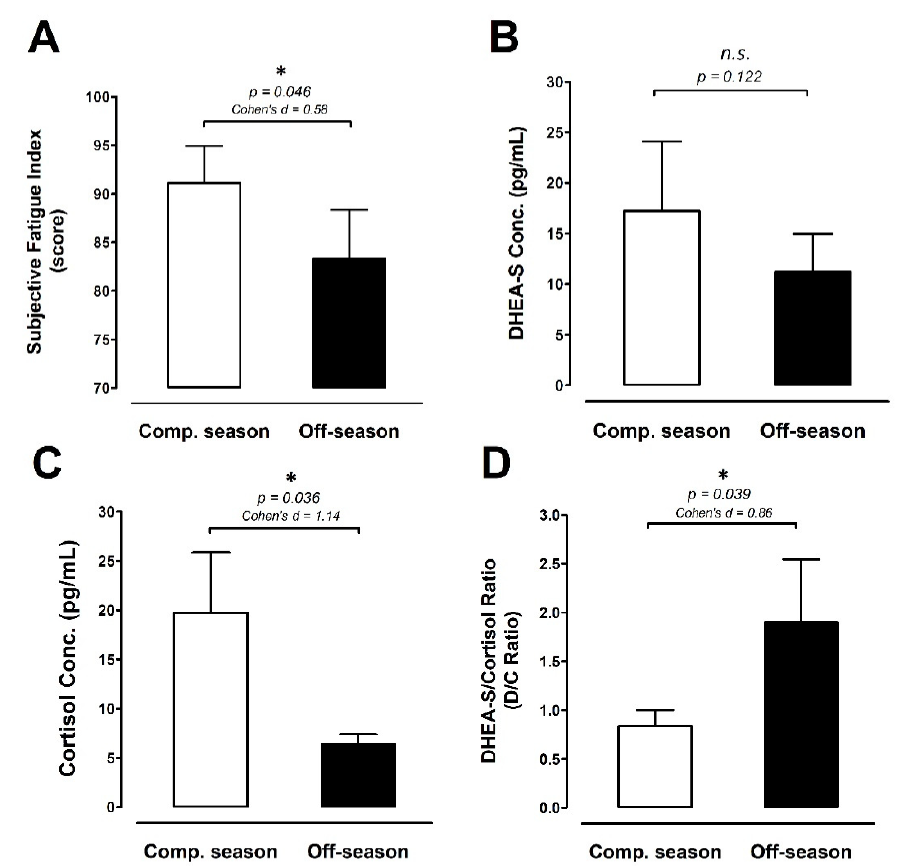
Figure 5. Fatigue and stress-related biomarkers. ( A ) Subjective fatigue index, ( B ) DHEA-S concentration, ( C ) cortisol, and ( D ) D/C ratio were measured at the competitive season and off-season (competitive season, open bar; off-season, black bar). Data are expressed as mean ± S.E.M. * denotes significant difference between two phases ( p < 0.05). Comp. season: competitive season (CS), off-season (OS), D/C ratio: DHEA-S/Cortisol ratio.